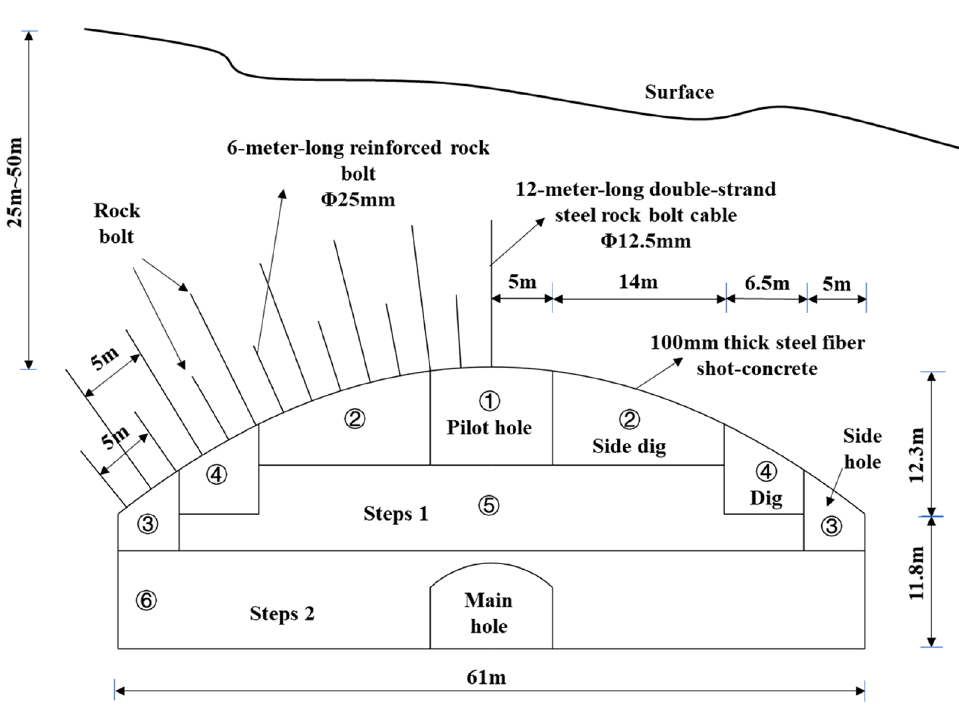
Figure 4. Layout of rock bolts on the roof of the Norwegian Olympic ice hockey stadium in gjøvik 18